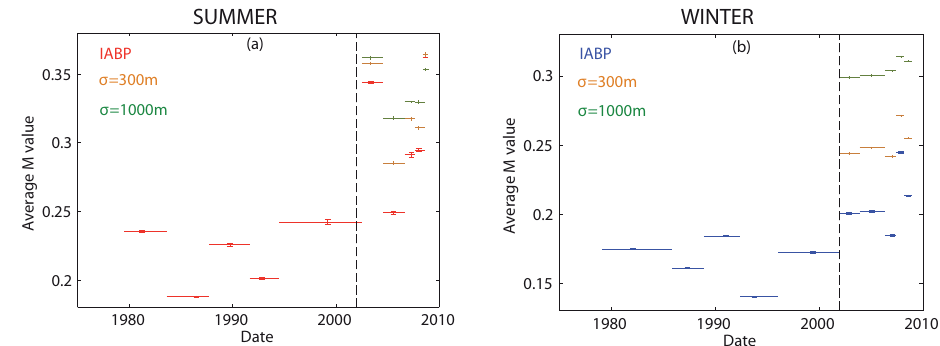
Fig. 11. Influence of noise, prescribed on the positions of buoys, on the monthly mean time series M(t) for (a) the summer season and (b) the winter season. Gaussian noise, with a constant standard deviation σ , has been added to all buoy positions recorded since year 2002. Results for noised mean time series M N (t) (in yellow and green) for σ = 300m and σ = 1000m are compared with the IABP mean time series M(t) as in Fig. 10.